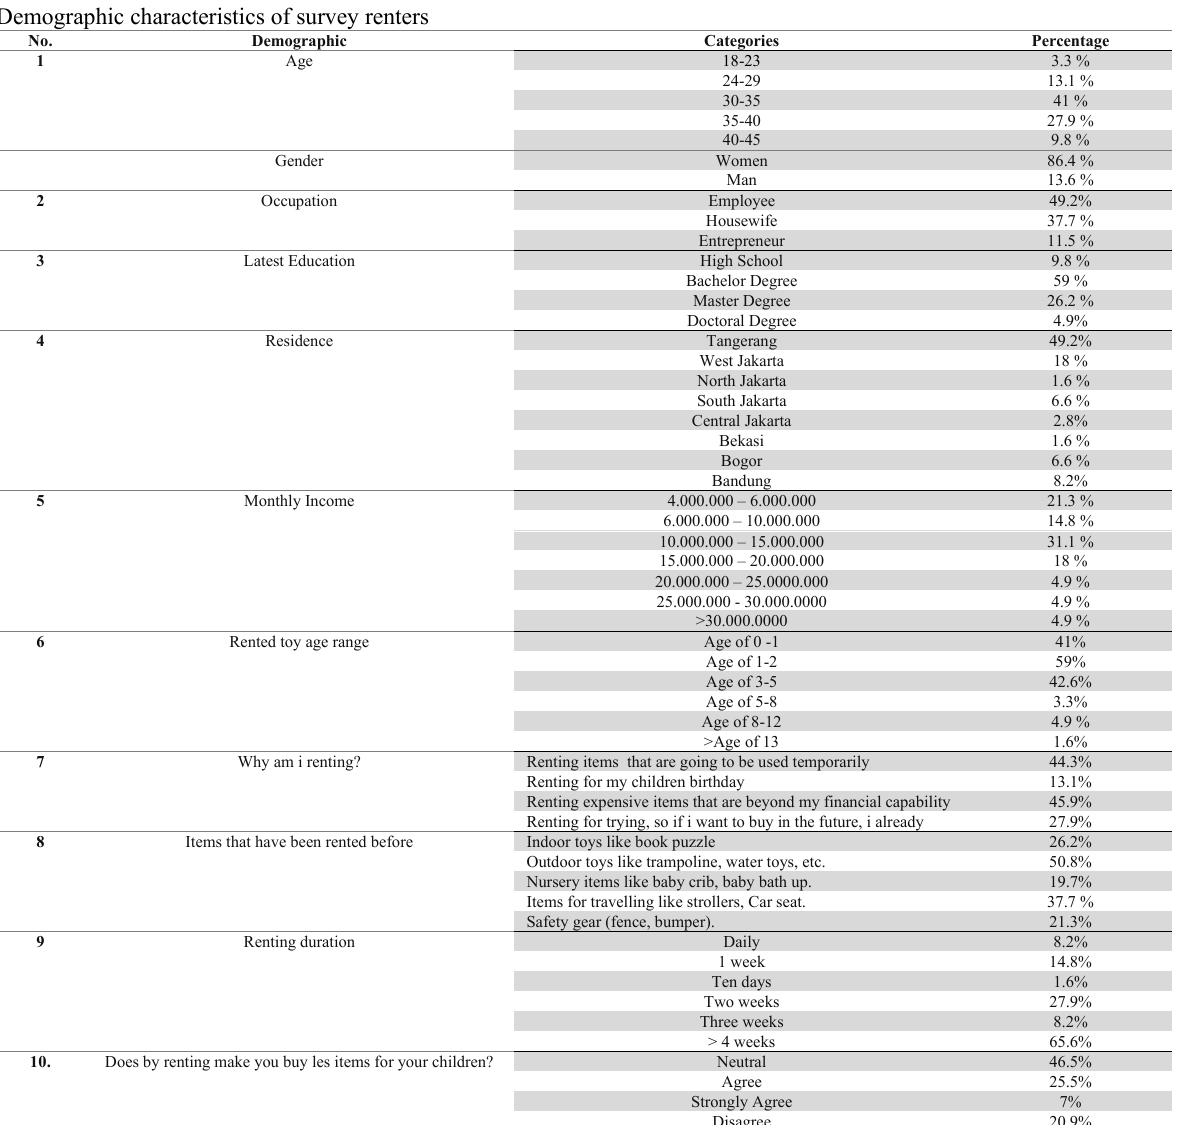
Demographic characteristics of survey renters